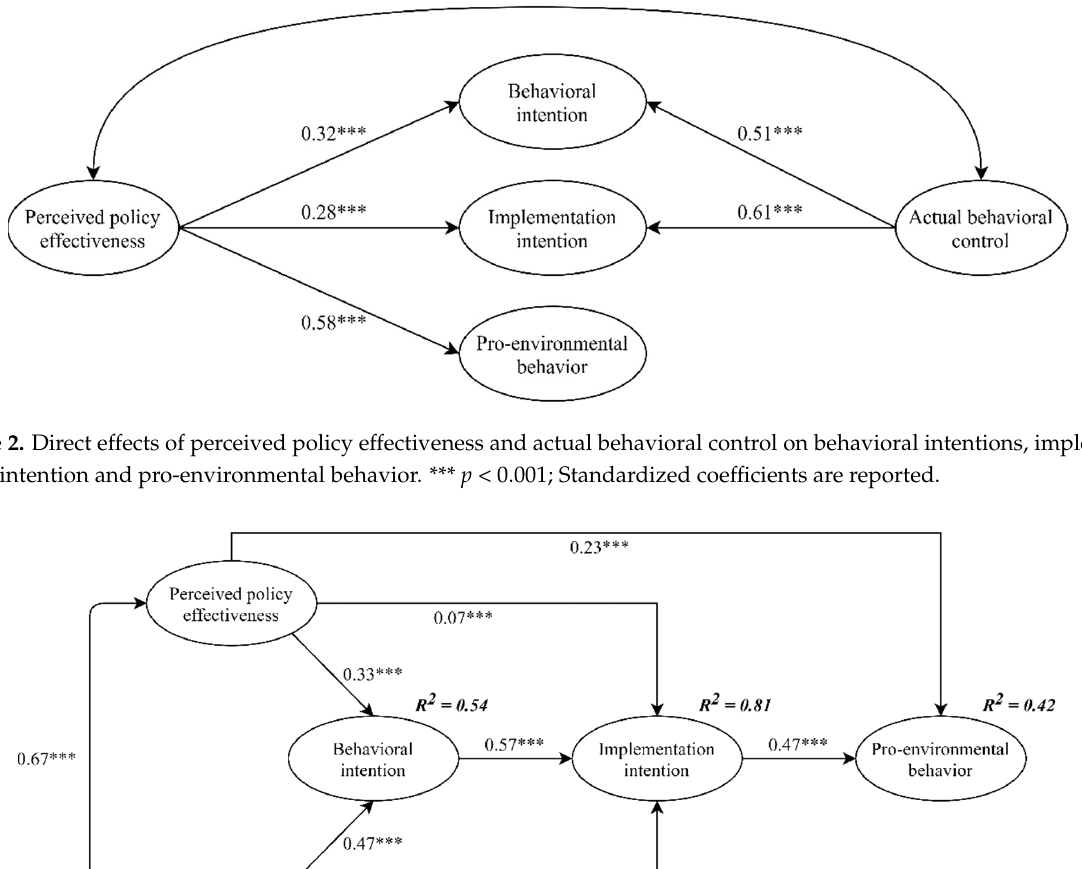
Figure 2. Direct effects of perceived policy effectiveness and actual behavioral control on behav-